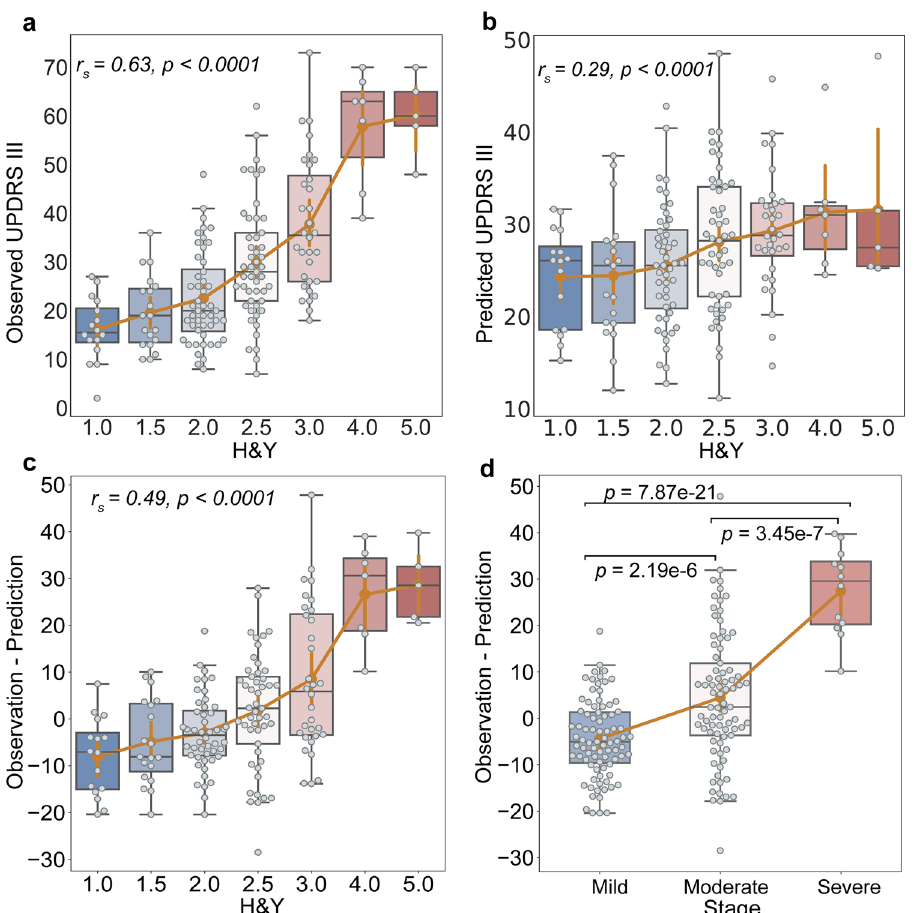
Fig. 5 Stage-speci fi c analysis of the DPN predictive model. Using the samples showed a relatively accurate performance ( R 2 > 0), Study 1 to 3 ( n = 176) were aggregated to evaluate the predictive performance of DPN along with PD progression. a We delineated the observed UPDRS III scores at different H&Y stages, and found a signi fi cant correlation (Spearman ’ s r = 0.63, P < 0.0001). b We showed the relationship between predicted UPDRS III scores and H&Y stages (Spearman ’ s r = 0.29, P < 0.0001). c We correlated the residuals between observations and predictions with H&Y stages (Spearman ’ s r = 0.49, P < 0.0001). d Based on the H&Y, patients were divided into mild (H&Y = 1, 1.5, 2; n = 83), moderate (H&Y = 2.5, 3; n = 81), and severe (H&Y = 4, 5; n = 12) groups. Signi fi cant differences in predicted deviations were revealed between each pair of groups using two-sample t -tests. Boxplots indicate the median (the black line in the box), upper and lower quartiles (box), 1.5 times interquartile range (whiskers) and outliers (circles) for the values in each stage. DPN discordance predictive